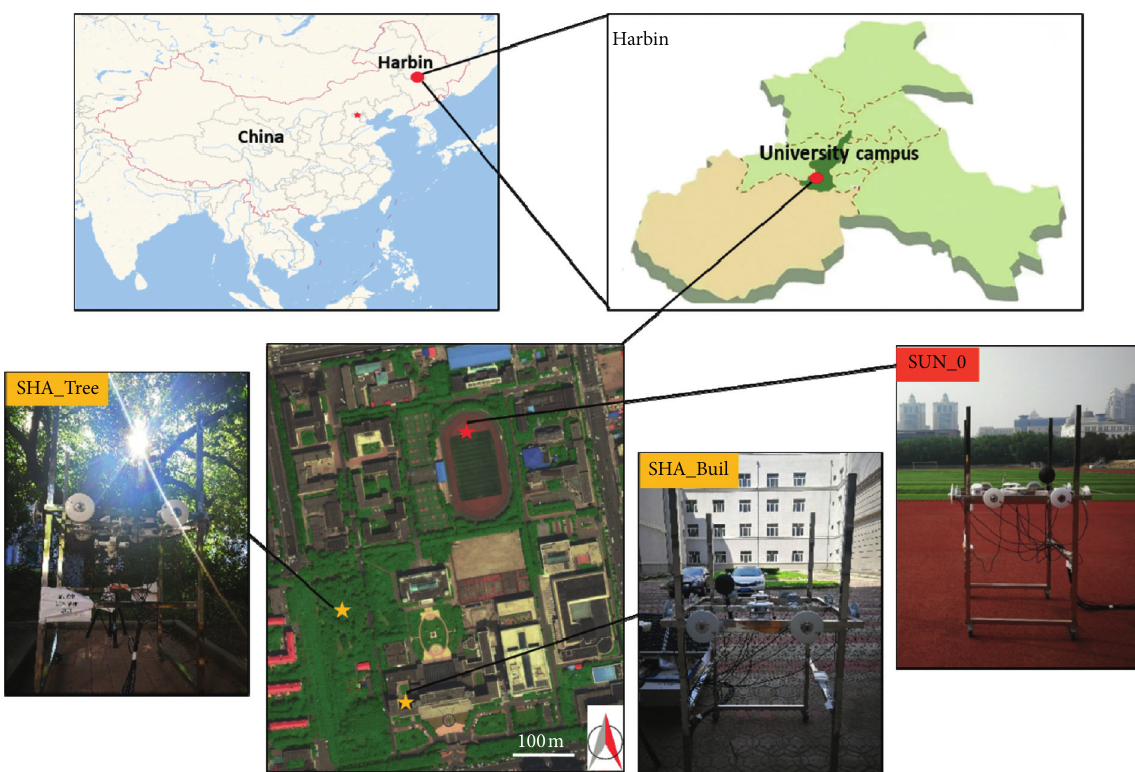
Figure 1: Location of Harbin and the distribution of the research sites in the university